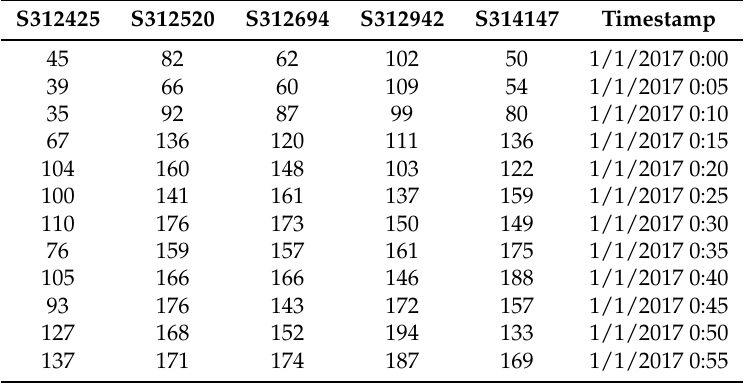
Table 1. A sample of the traffic counts from Phase 1-Train.